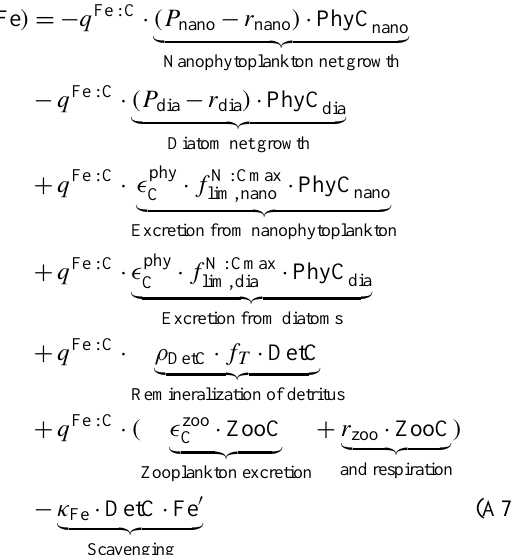
ratio ( q Fe:C ; Table A6). Biological uptake and release of iron is likewise connected to uptake and release of carbon.